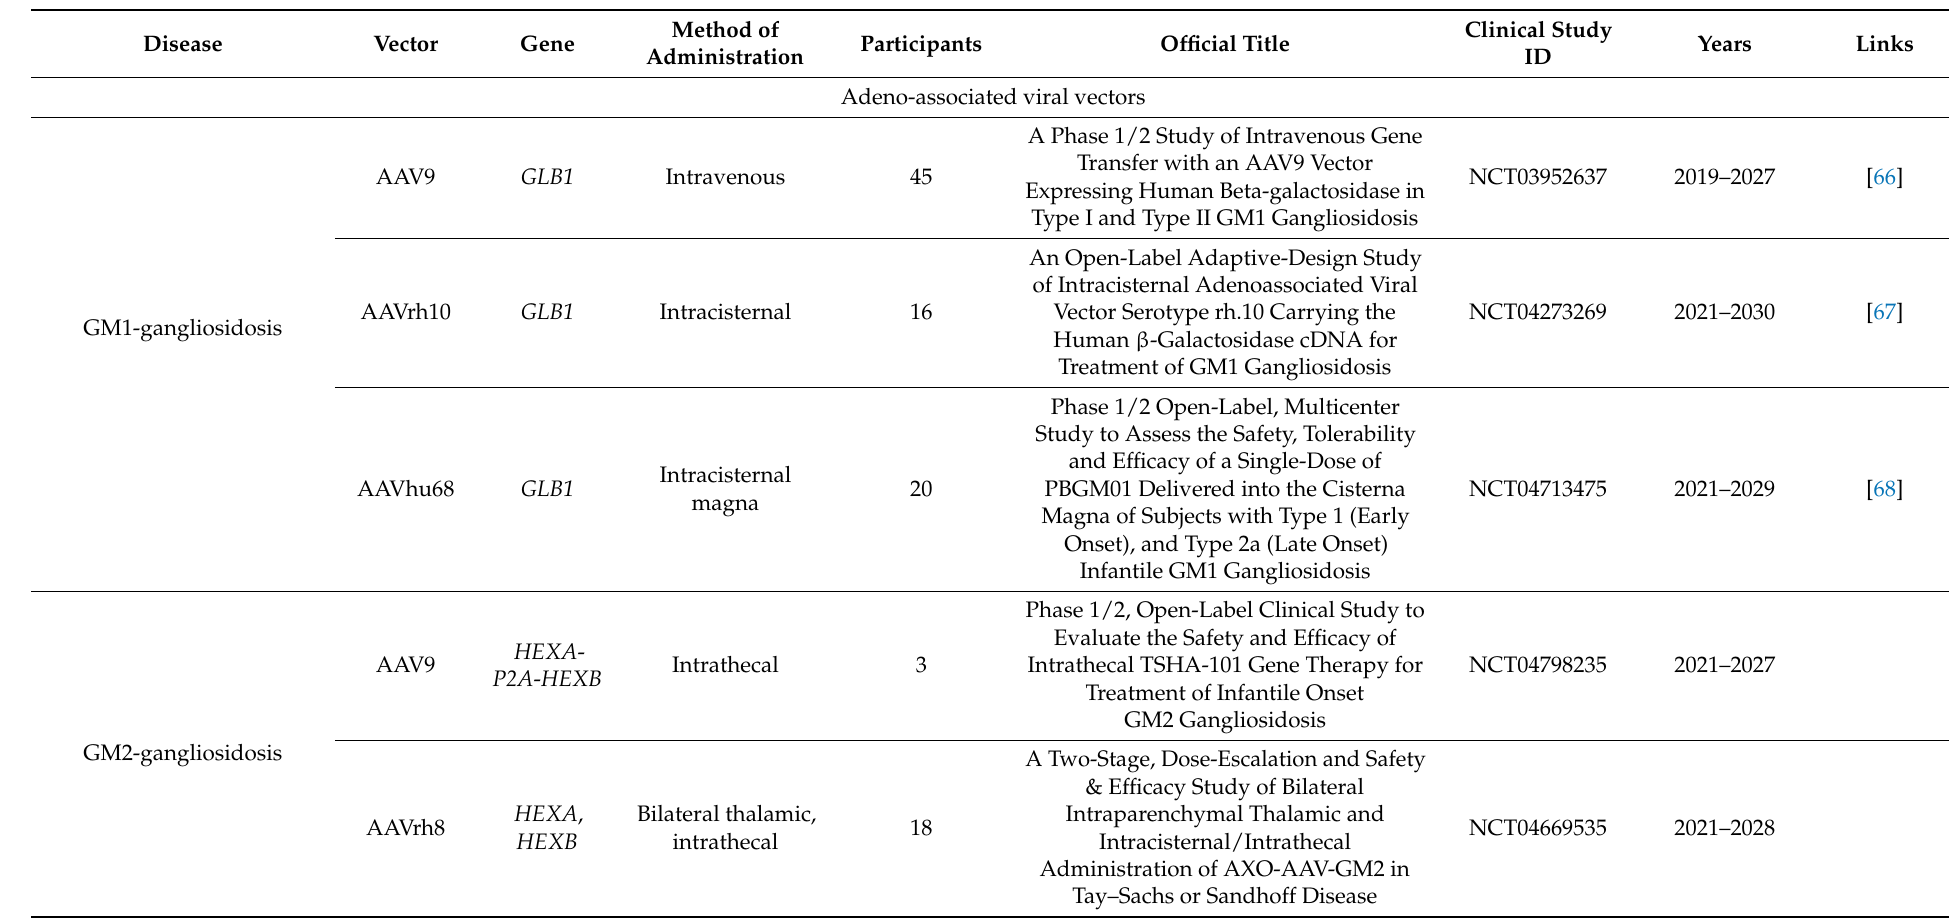
Table 2. Clinical studies of gene therapy methods for the treatment of